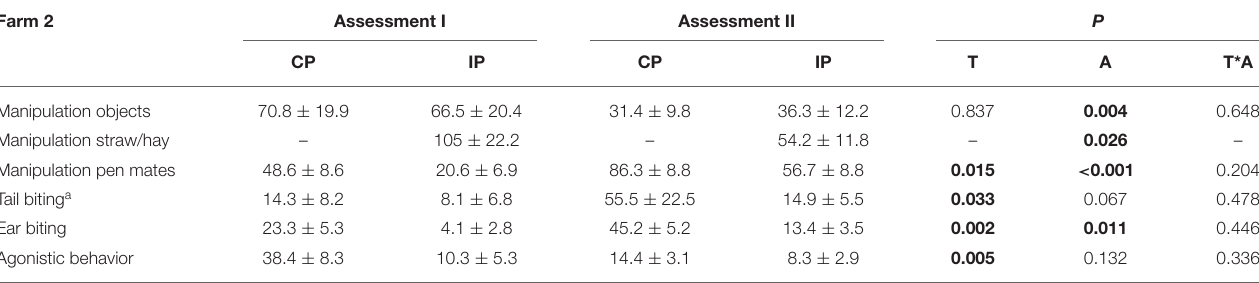
TABLE 5 | Frequency of behaviors (number of events/100 animals * 10min; LS-means ± standard error of means) for pigs in IP (improved pens) and CP (control pens) during assessments I (baseline) and II (middle of the fattening period) on Farm 2. Farm 2